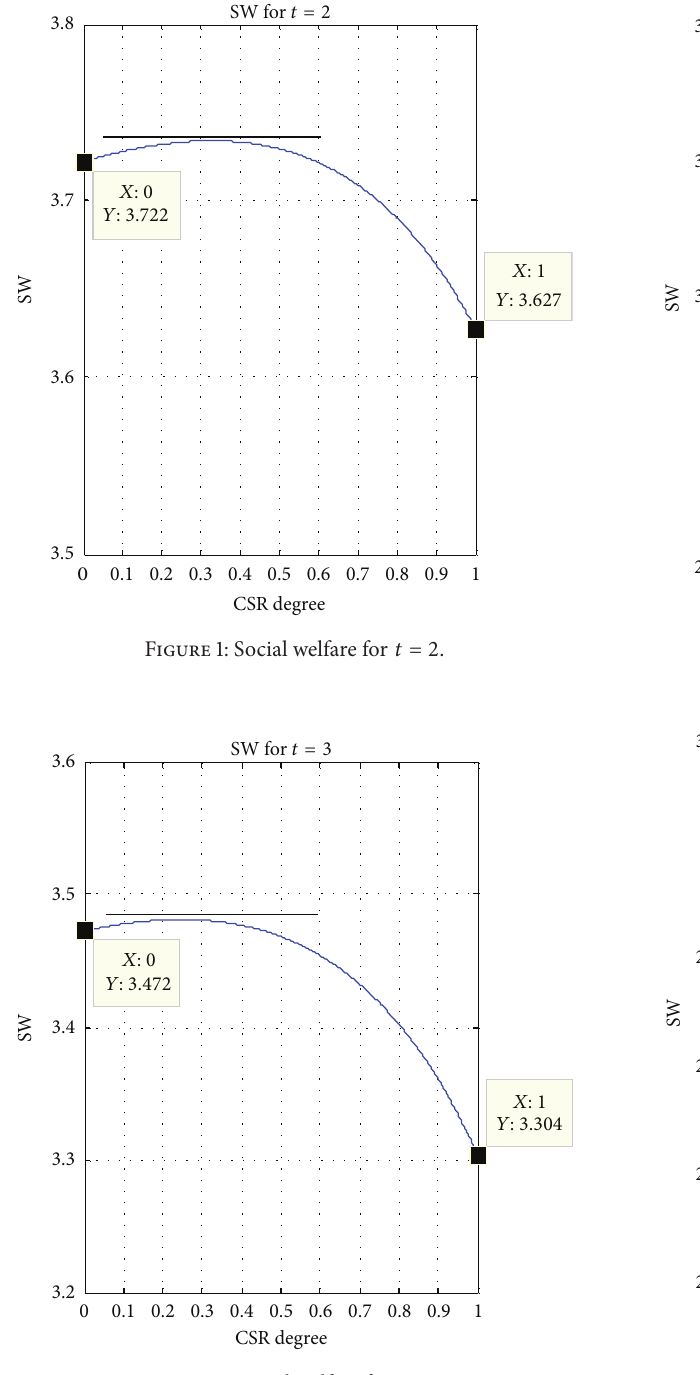
Figure 2: Social welfare for 𝑡 = 3 .